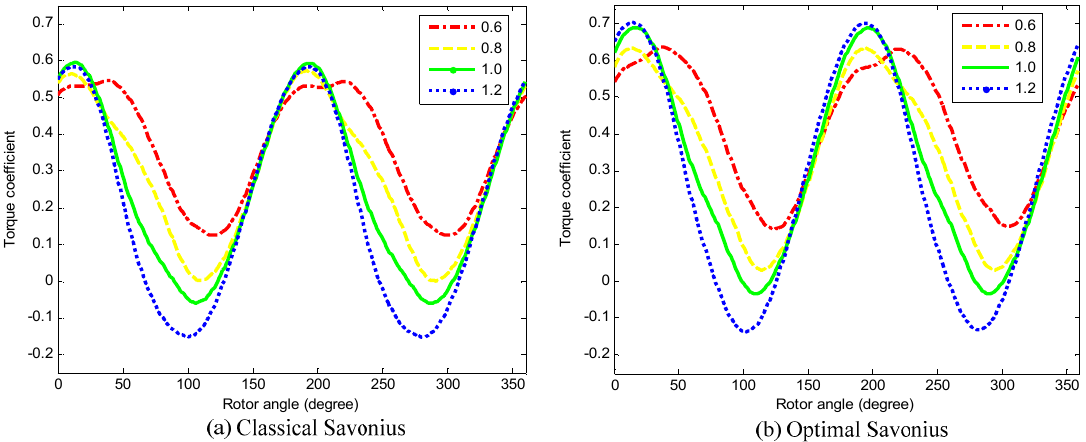
Figure 20. ( a ) Classical Savonius and ( b ) optimal Savonius: comparison of the torque coefficient for the four TSRs .